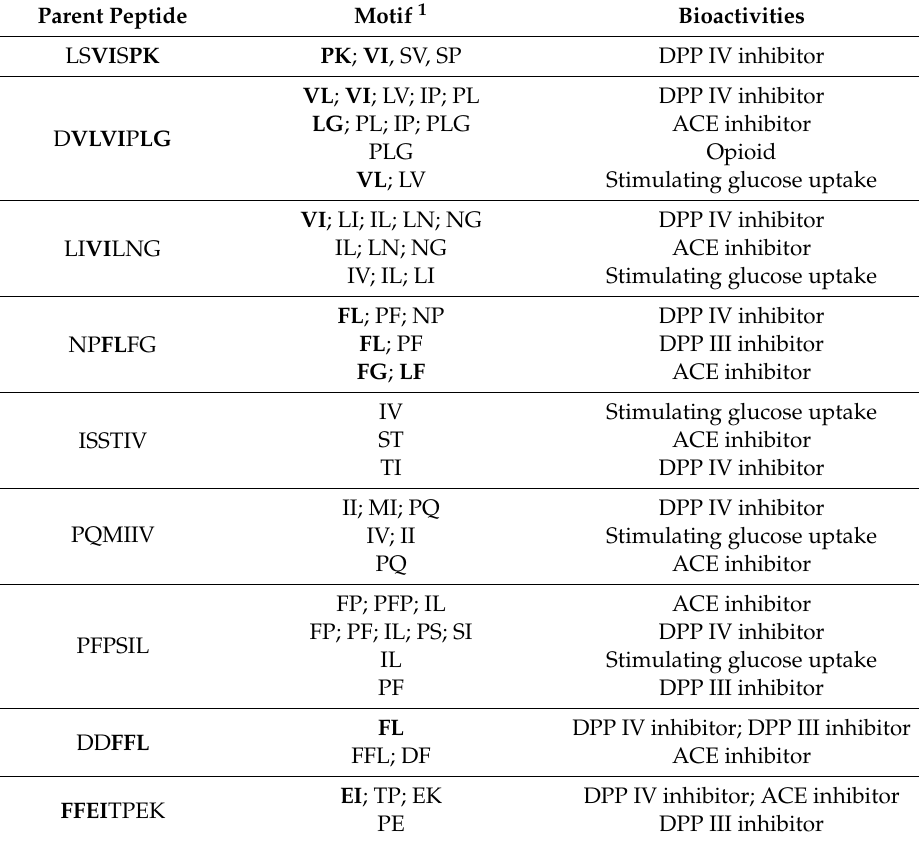
Table 4. Additional bioactivity of bitter motifs found in parent peptides identified in SPC (soybean protein concentrate) hydrolysate